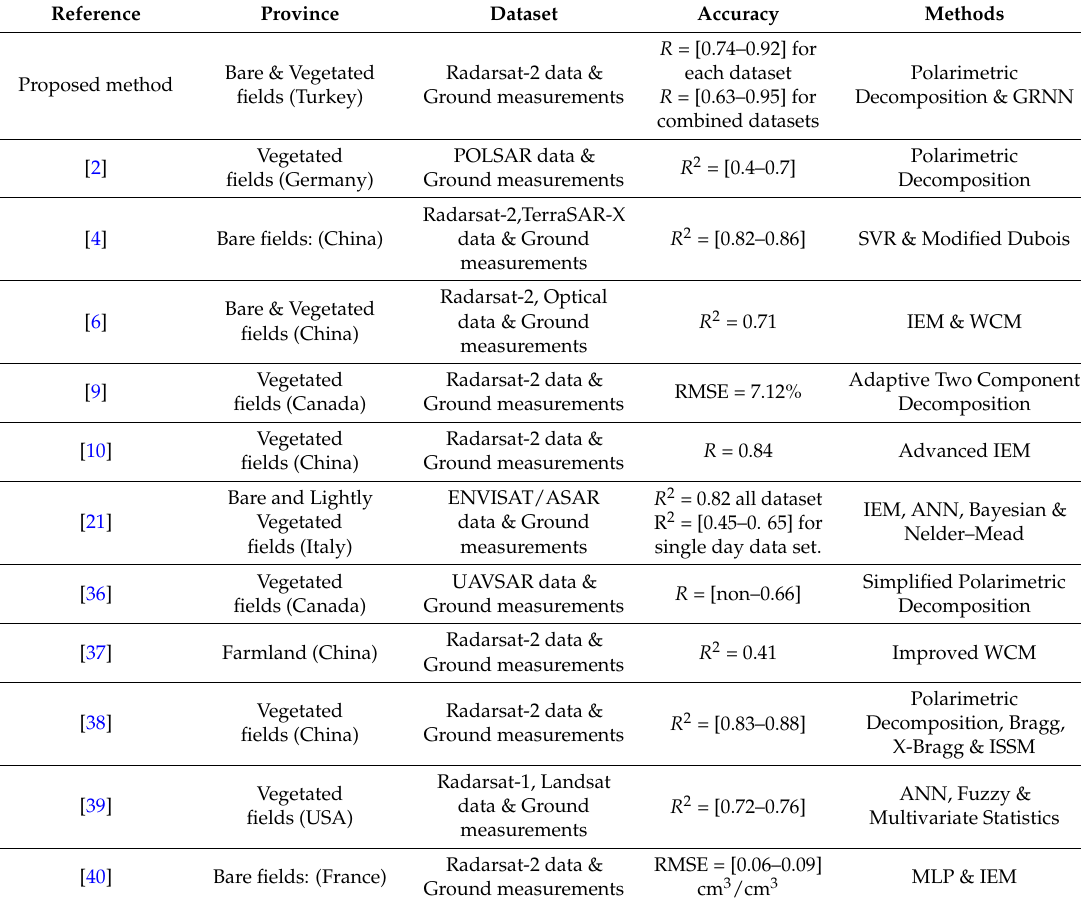
Table 4. The comparison of different approaches for estimating soil moisture by SAR-based